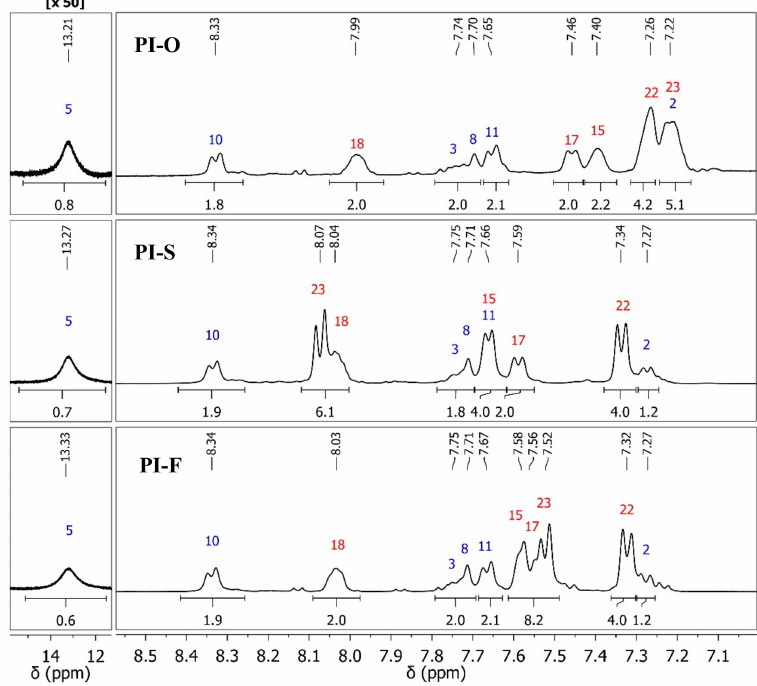
Figure 3. Selected region of the 1 H NMR spectra (400 MHz, DMSO- d 6 ) for